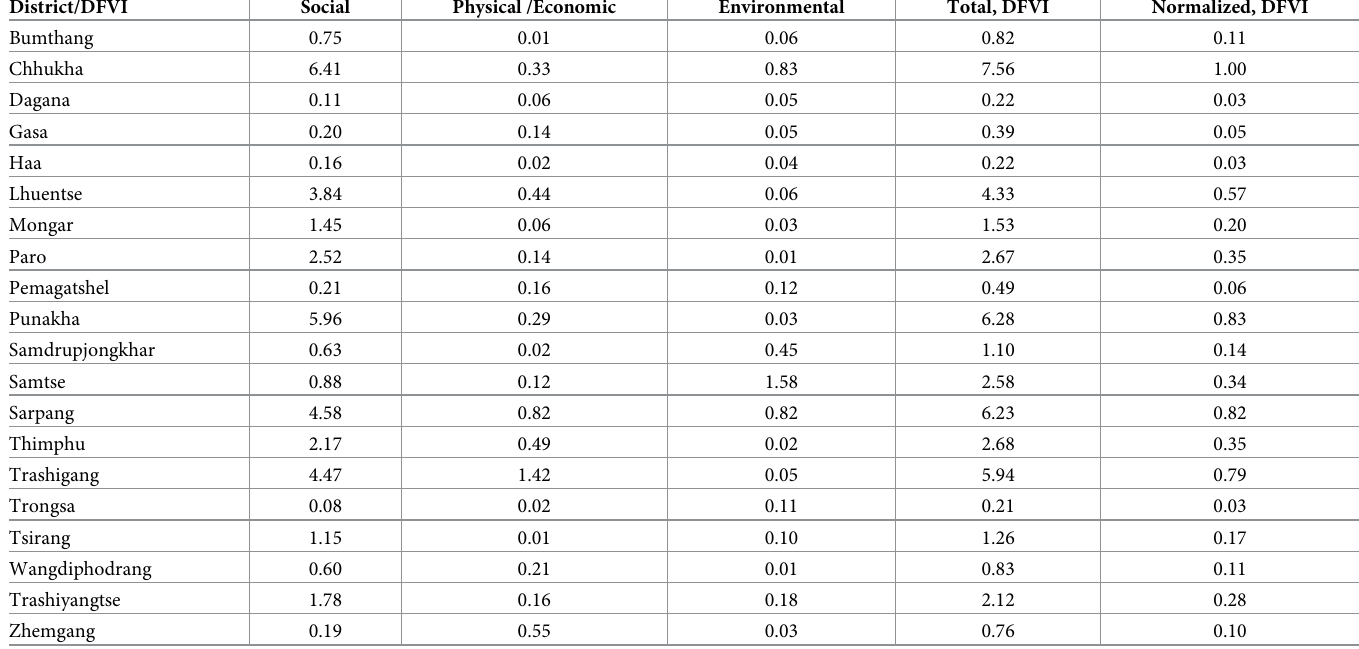
Table 10. Final DFVI for all